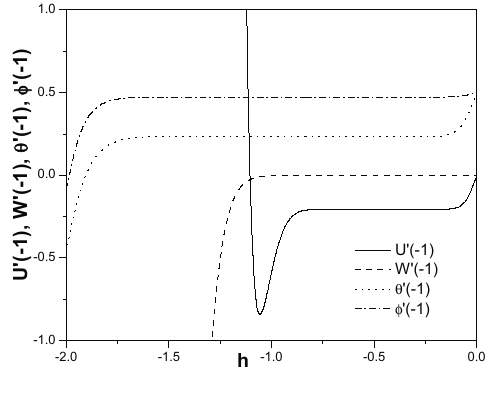
Fig. 2: The h -curves of U (cid:2) ( η ), W (cid:2) ( η ), θ (cid:2) ( η ) and ϕ (cid:2) ( η ) when β = 1.0, Ha = 2.0, B = 1.0, R = 1.0, A = 1.0, Pr = 0.71, B i = 2.0, Sc = 0.22, B h = 2.0, Sr = 0.3, Br = 0.5